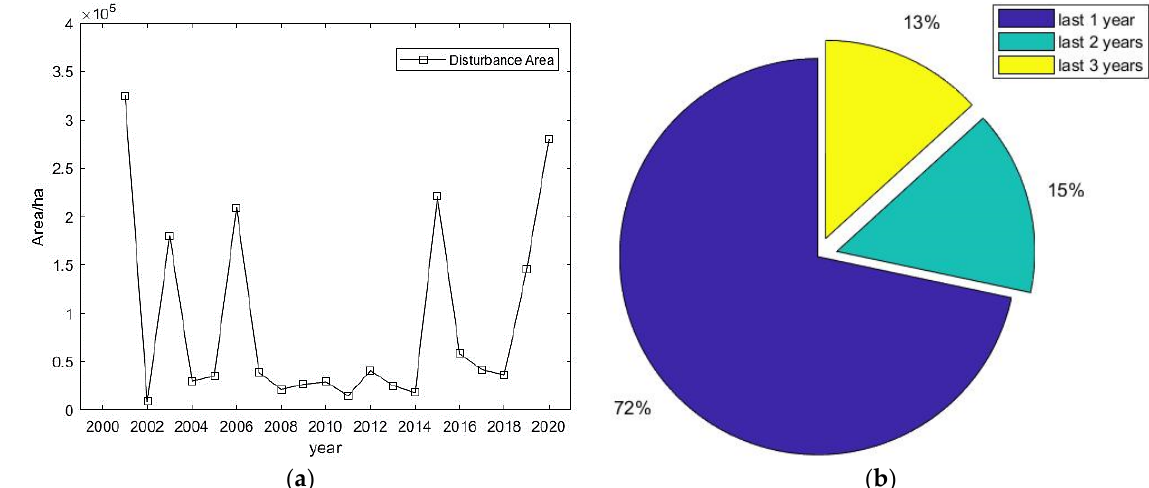
Figure 11. ( a ) Disturbance area and ( b ) duration year, in Great Khingan Mountain (GKM), China.